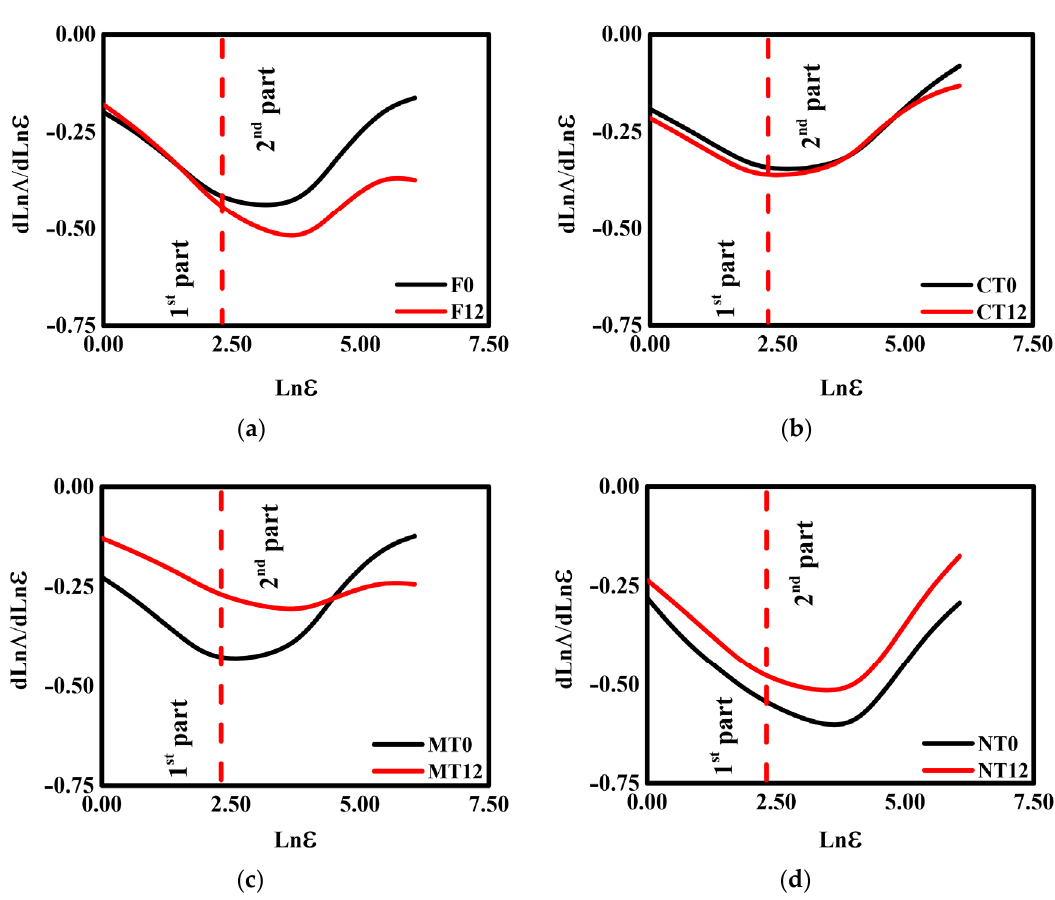
Figure 1. 3D lacunarities ( Λ ) of the samples submitted to 0 and 12 wetting and drying (W-D) cycles. ( a ) Secondary forest—F; ( b ) conventional tillage—CT; ( c ) minimum tillage—MT; ( d ) no till- age—NT. The divisions into two parts (first and second) were made based on the regions where the best linear adjustments occurred in the curves. ε is the box size.